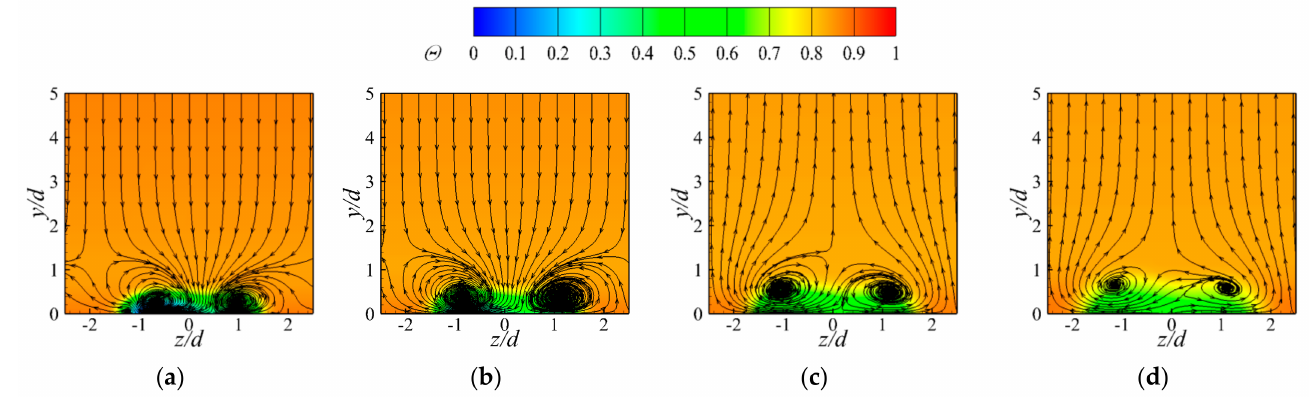
Figure 18. Dimensionless temperature contours and streamlines in downstream normal sections on the suction side for DJFC ( Z / d = 1.0 and β = 29 ◦ ) under M = 1.5. ( a ) s / d = 3, ( b ) s / d = 6, ( c ) s / d = 12, ( d ) s / d = 18.